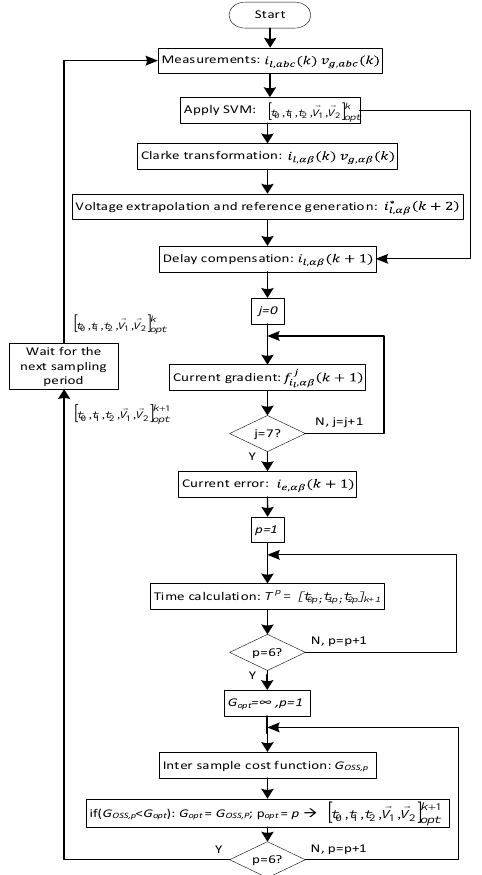
Figure 10. The implemented flowchart of the